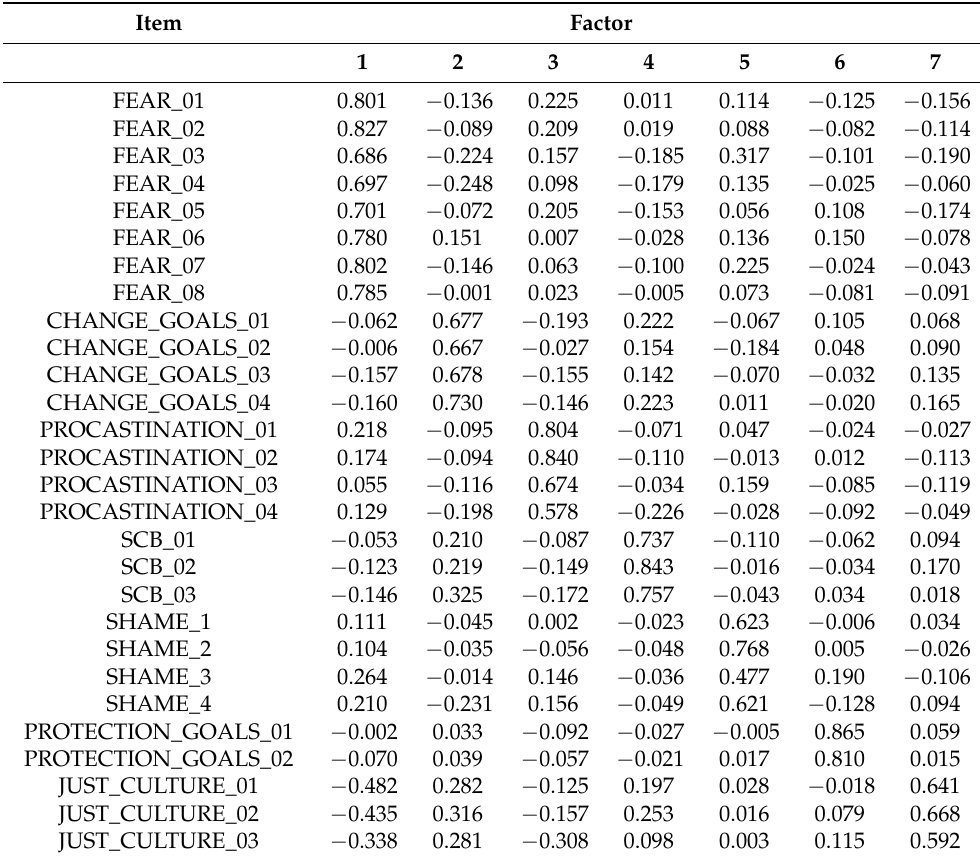
Table A2. Results of factor